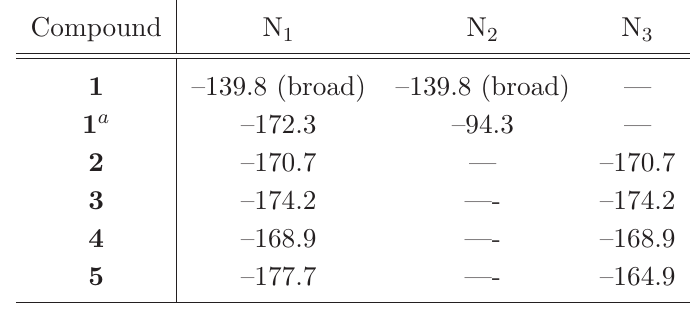
Table 2 15 N NMR chemical shifts (ppm referenced to nitromethane) for azoles 1 - 5 in CDCl 3 .